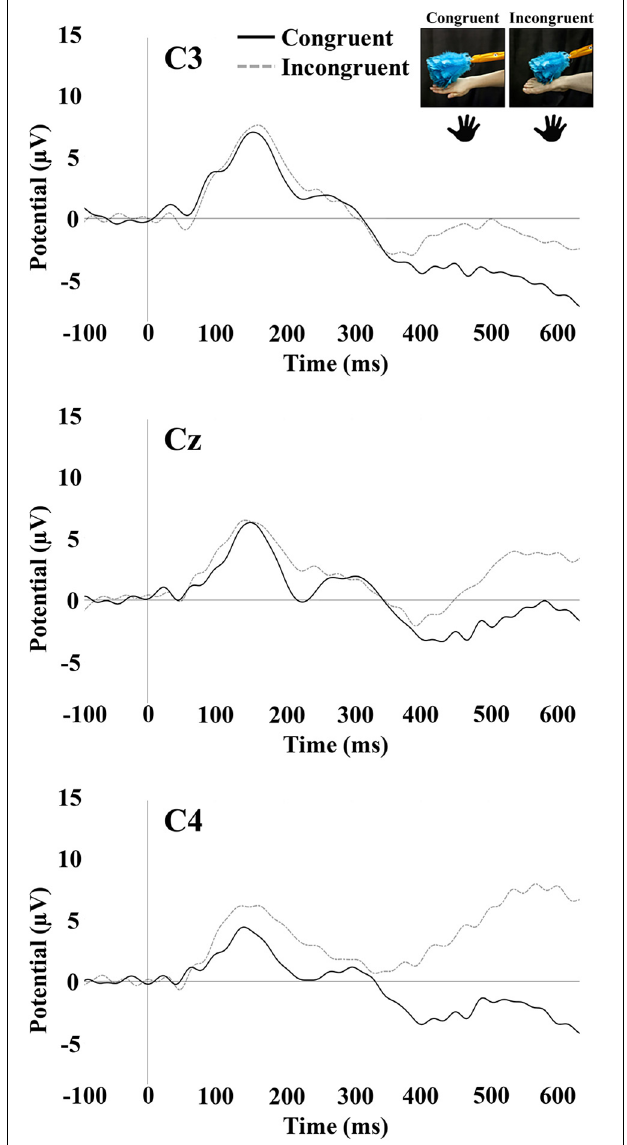
FIGURE 3 | SEP responses to tactile stimulation of the infant’s right hand. The plots display responses at central electrode sites C3, Cz, and C4. Hand icons indicate the infant body part receiving tactile stimulation. The photographs depict the live visual event the infants